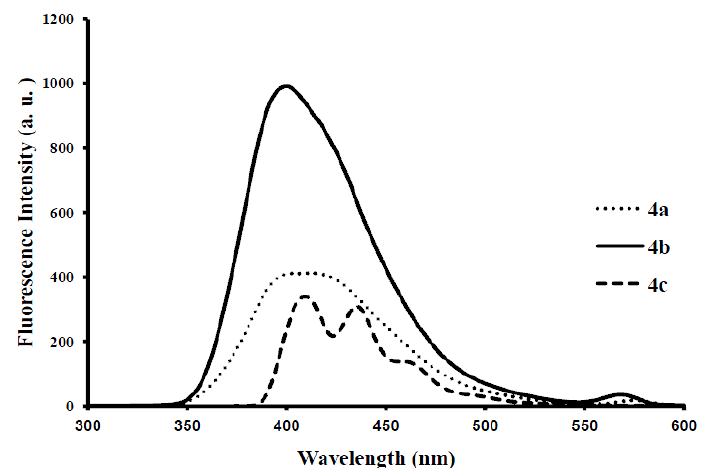
Figure 6. The fluorescence emission spectra of 4a – c ( λ (conc. 2.0 × 10 − 7 mol/L) at